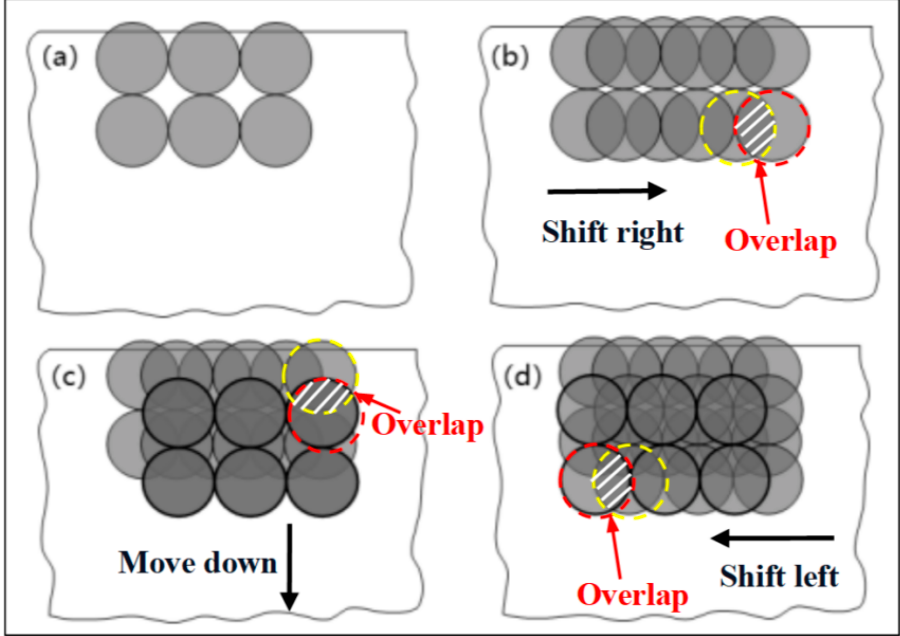
Figure 2. Schematic diagram of the laser shock method. ( a ) The first laser shock; ( b ) the second laser shock; ( c ) the third laser shock; ( d ) the fourth laser shock.